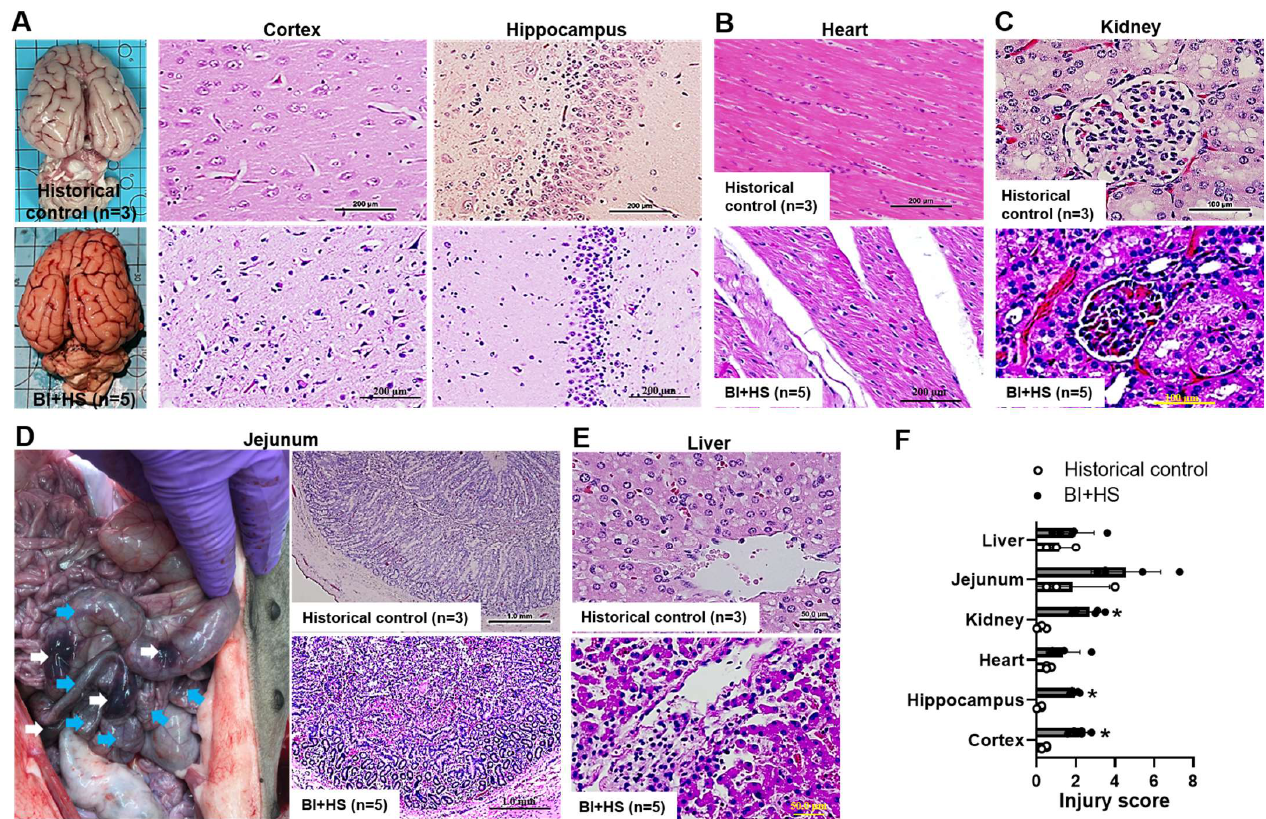
Figure 4. BI+HS induces histological changes in porcine brain ( A, scale bar = 200 µm), heart ( B, scale bar = 200 µm), kidney ( C , scale bar = 100 µm), jejunum ( D, scale bar = 1 µm), and liver ( E, scale bar = 50 µm). Organ injury scores based on the criteria described in the Materials and Methods ( F ). n = 5. The data are expressed as mean ± SD. * p < 0.05 vs. historic control (n =